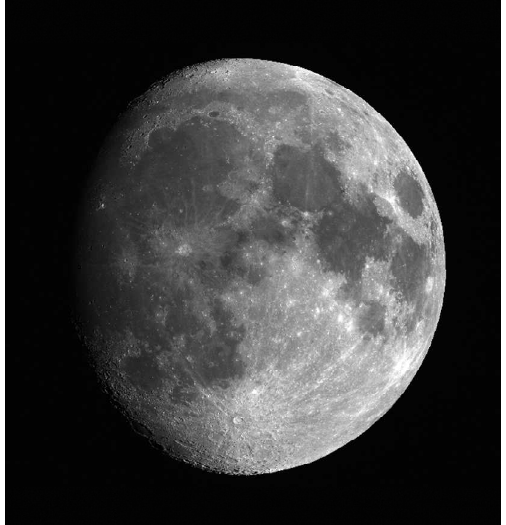
Figure 5: Acquisition of the moon, acquired by PLEIADES the